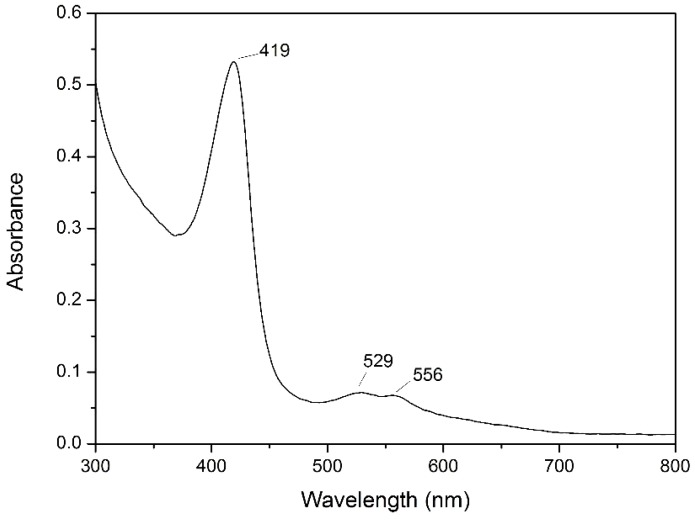
UV-visible spectrum of the purified CD2-MnP.